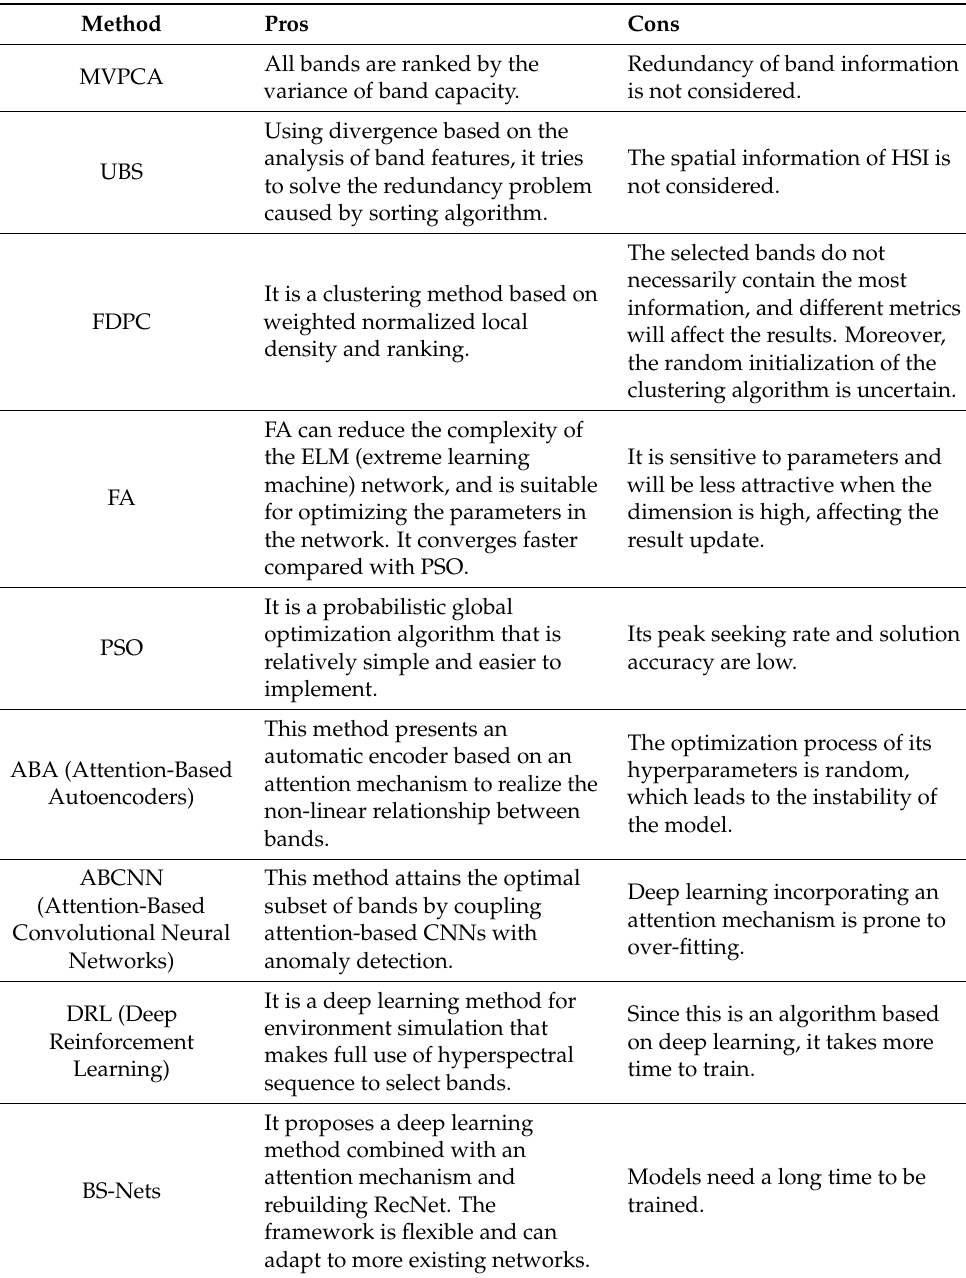
Redundancy of band information is not considered. not